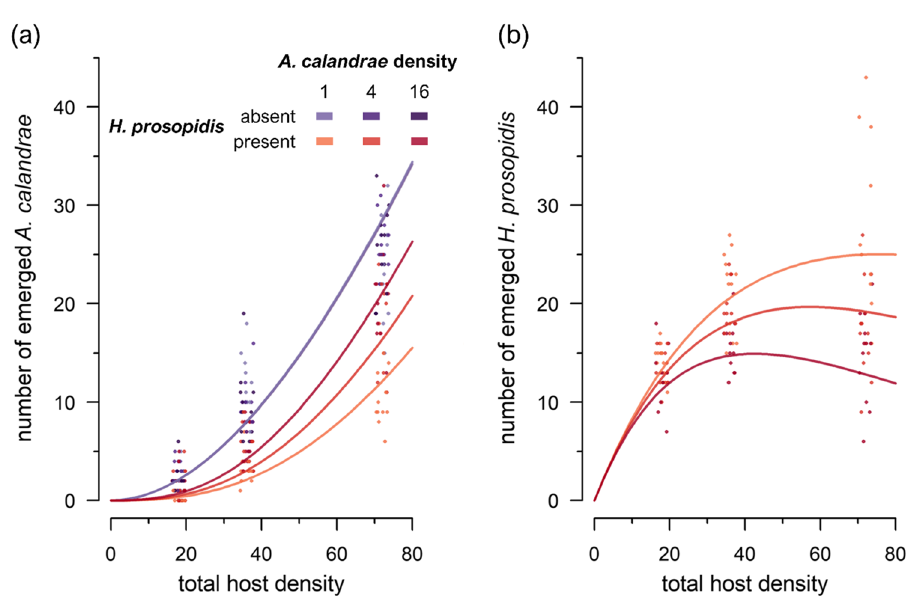
Figure 4. Population responses to host density for ( a ) the native parasitoid Anisopteromalus calandrae and ( b ) the nonnative parasitoid Heterospilus prosopidis . Solid lines depict the prediction by our Nicholson–Bailey-type model. Note that the model lines for H. prosopidis absent (purple) overlap considerably among different A. calandrae densities. Jittering as in Fig.